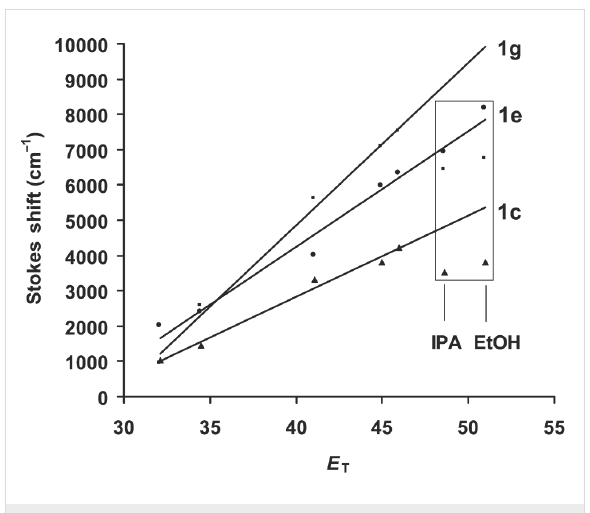
Figure 6: Correlation of Stokes shift with E T (30)